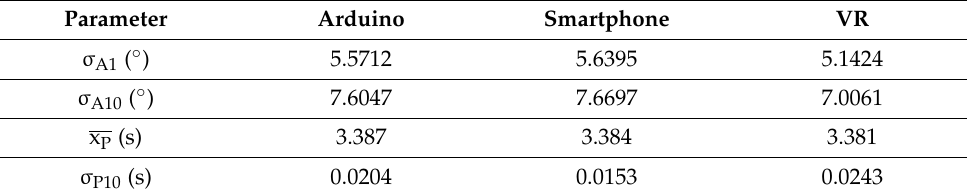
Table 4. Statistics for the orientation data calculated for the representative devices of all three types.